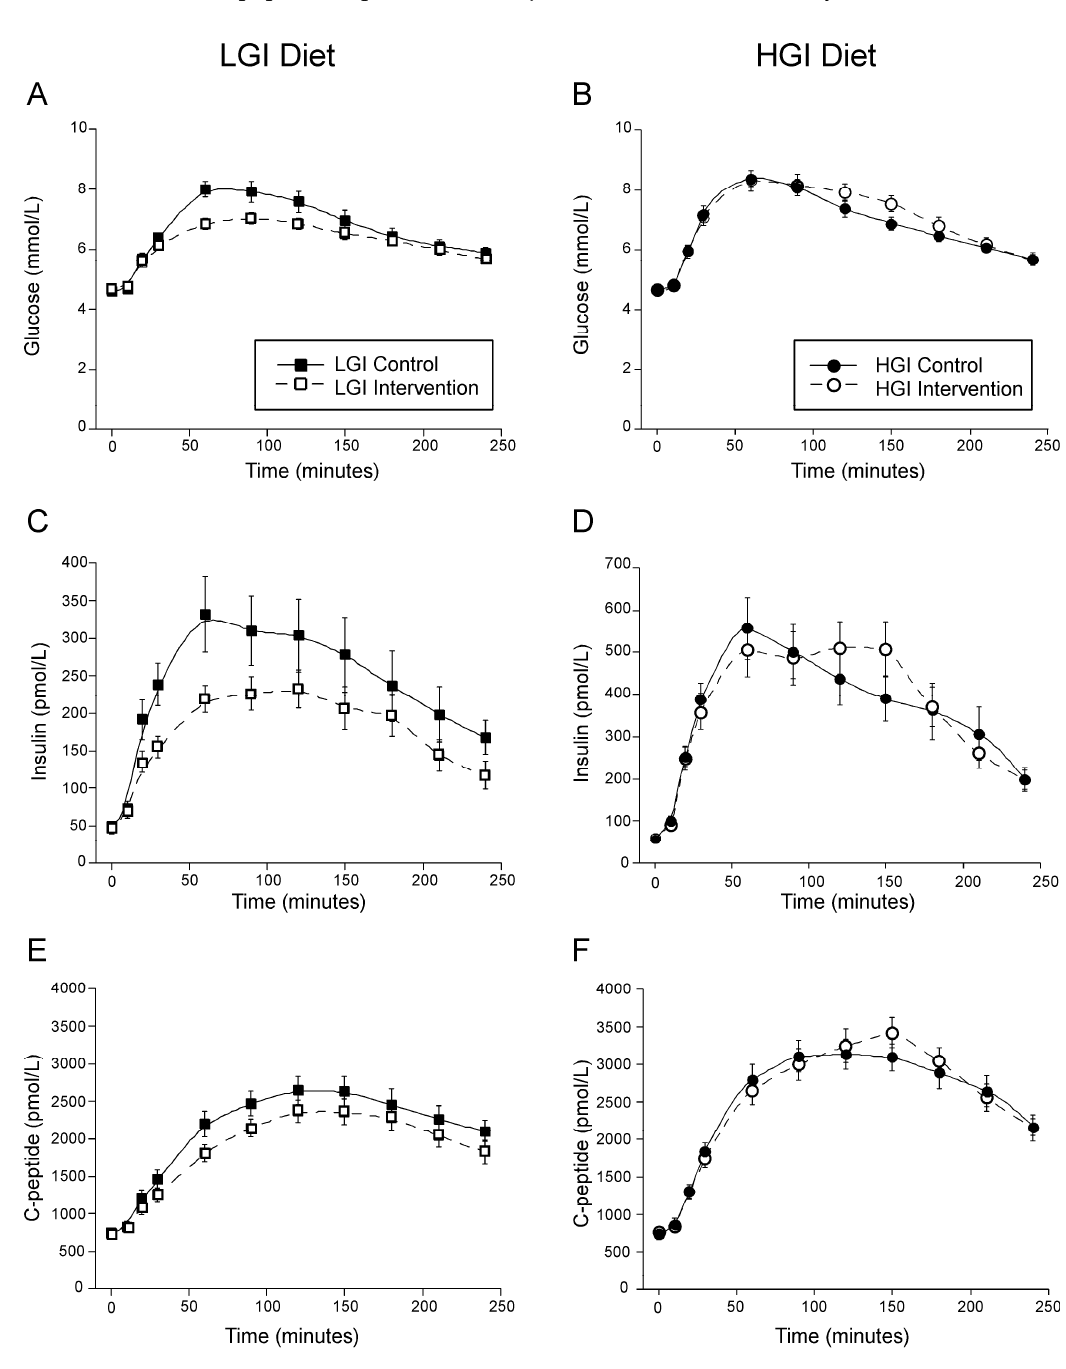
Figure 1. Glucose ( A , B ), insulin ( C , D ) and C-peptide ( E , F ) concentrations during the MTT. The LGI diet is depicted by squares and the HGI diet by circles. The Control diet is denoted by solid symbols and a solid line, and the intervention diet by open symbols and a dashed line. Mean ± SEM. 3.3. Effect of Dietary Glycemic Index on Insulin Secretion Insulin secretion at a reference glucose of 5 mmol/L glucose did not change with the LGI diet but decreased on the HGI diet (Table 2). Total insulin secretion rates were lower on the LGI diet but did not change on the HGI diet compared to the Control diet; there